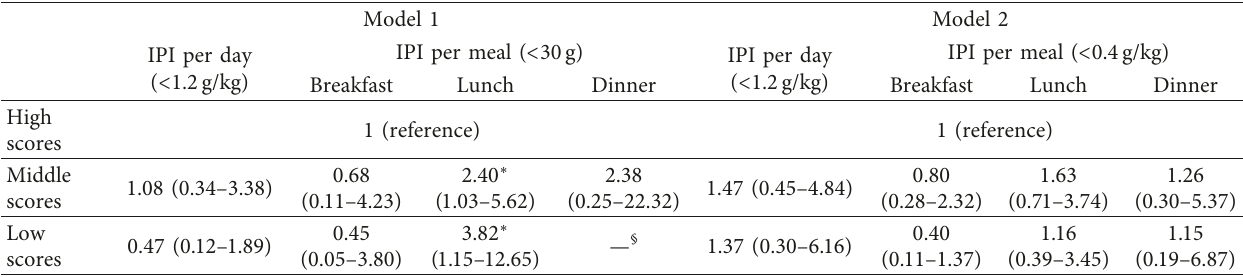
Table 5: Risk of impaired functionality for activities of daily living (ADL) related to the inadequate protein intake per day and per meal in middle to older aged Mexican adults ( n �